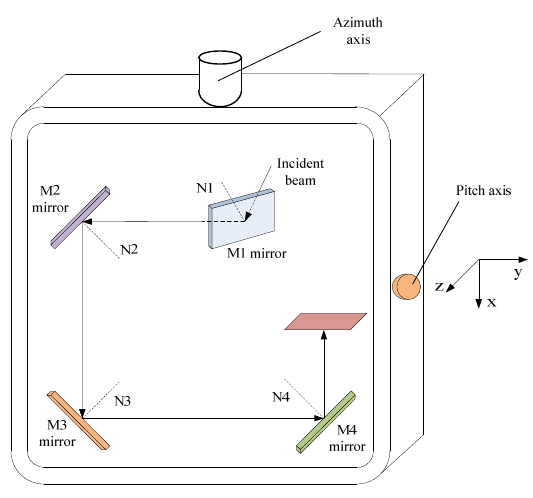
Figure 3. Imaging optical path of the system.